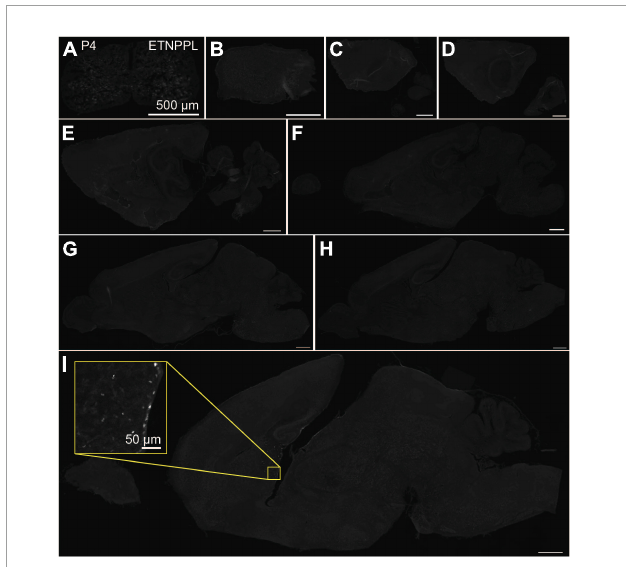
FIGURE4 Localization of ETNPPL in the whole brain in P4. Coronal section of the cervical cord (A) or parasagittal section (approximately 320 µ m interval) of the whole brain (B–I) of P4 female mice are shown. White indicates the ETNPPL signal revealed by IHC. Inset in a yellow box indicates an enlarged image. Scale bars: 50 µ m for the inset or 500 µ m for the other panels. The section images were appropriately rotated and cropped and the background was filled with black to minimize unnecessary